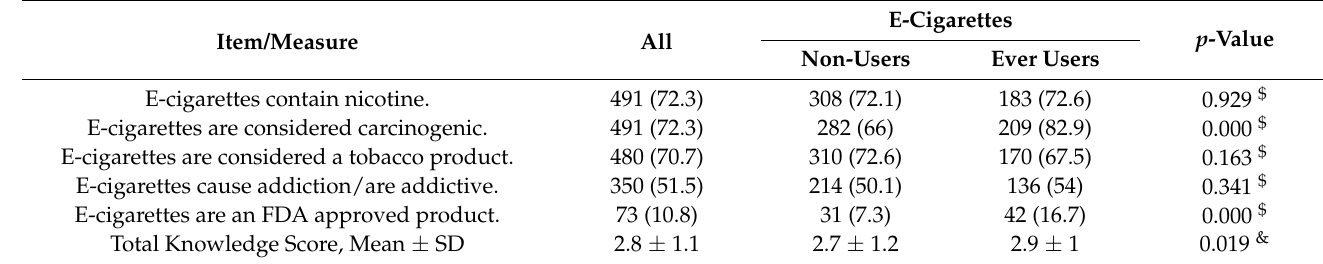
Table 4. Study Participants’ Level of Knowledge about E-cigarettes, N = 679.